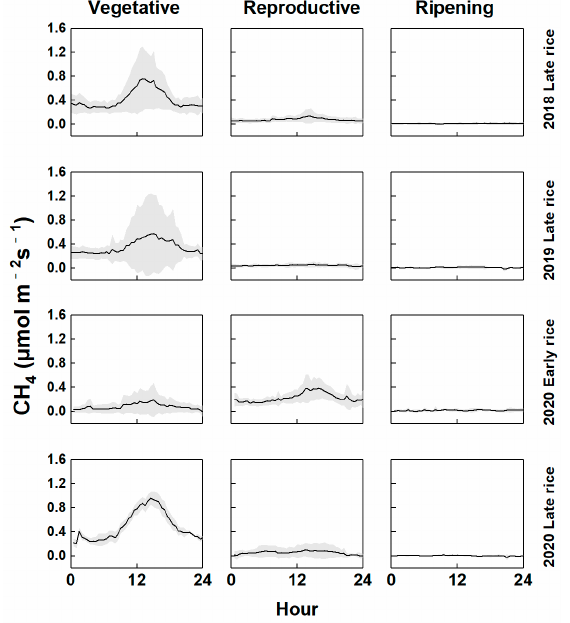
Figure 2. Diurnal variations in half-hourly CH 4 fluxes in the vegetative, reproductive and ripening stages of the rice growing seasons of 2018–2020 late rice and 2020 early rice. The grey shading represents the standard deviations of the half-hourly CH 4 fluxes.